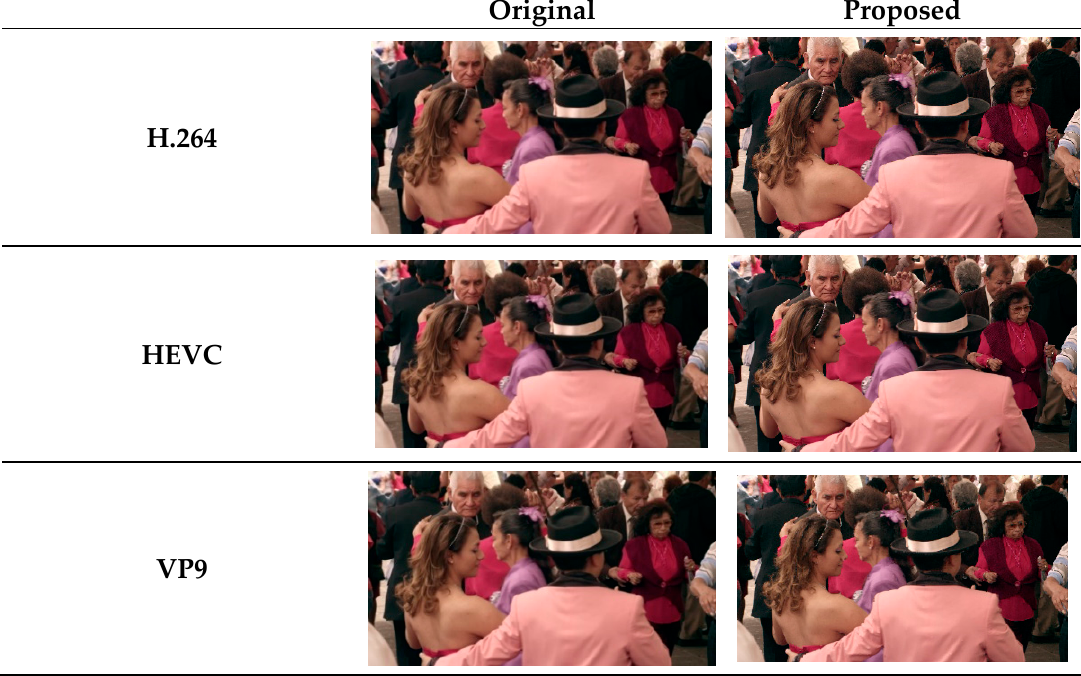
Figure 9. Subjective quality performance for the ‘Tango2’ sequence.